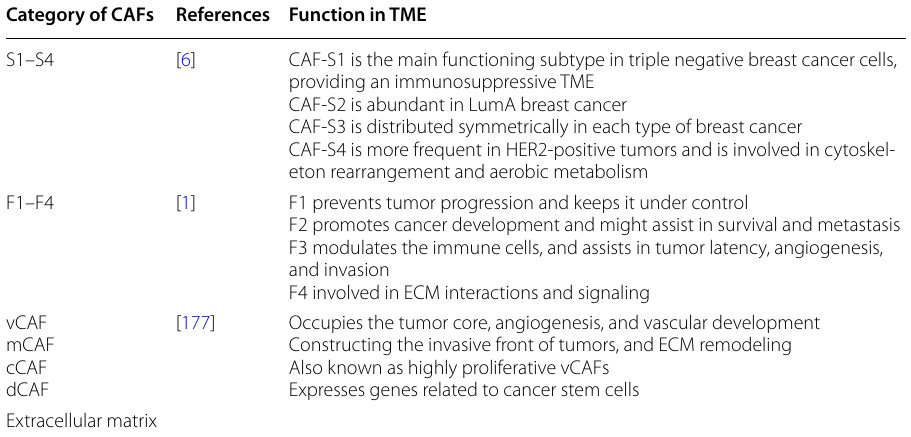
TME Tumor microenvironment, CAF cancer‑associated fibroblast, vCAF vascular CAF, mCAF matrix CAF, cCAF cycling CAF, dCAF developmental CAF, ECM extracellular matrix